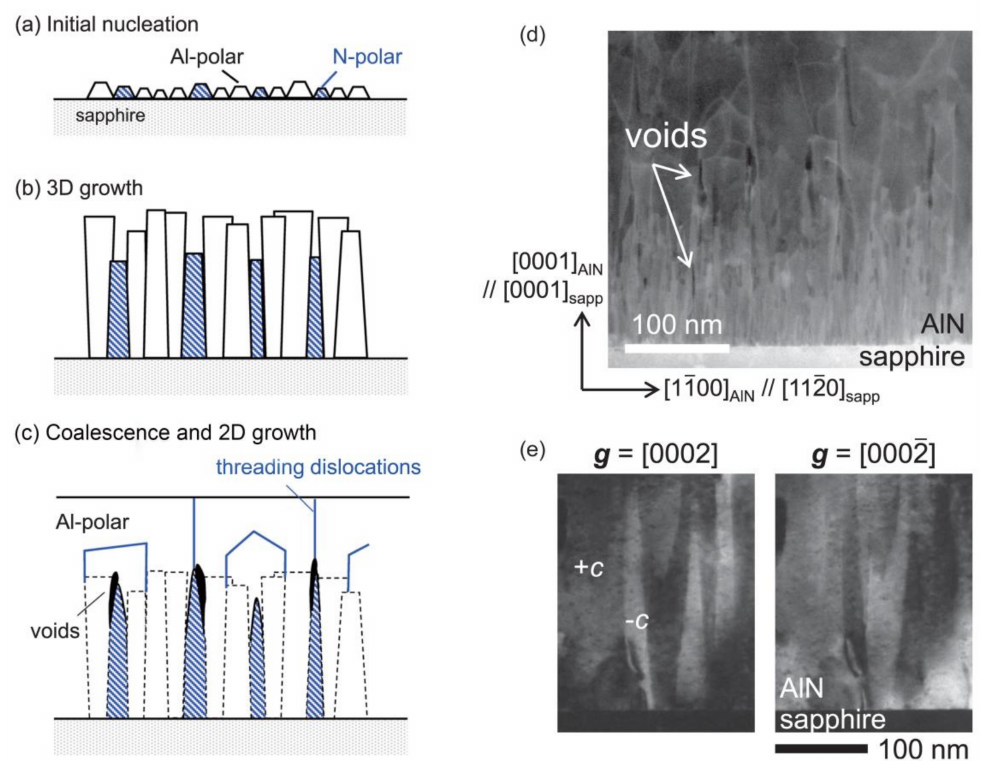
Figure 4. Schematic diagrams of the lateral burying process of N-polar AlN by Al-polar AlN: ( a ) the initial nucleation stage; ( b ) 3D growth stage; ( c ) coalescence and 2D growth stage; ( d ) cross-sectional TEM image of the lateral burying process of N-polar AlN by Al-polar AlN. Lots of voids formed above the N-polar AlN after the entire burying of N-polar AlN; ( e ) cross-sectional TEM dark field (DF) images taken at the same position using two-beam conditions. Lots of columnar structures with a width of tens of nanometers can be observed, indicating the co-existence of Al-polar AlN and N-polar AlN. Reprinted from [32], with the permission of AIP